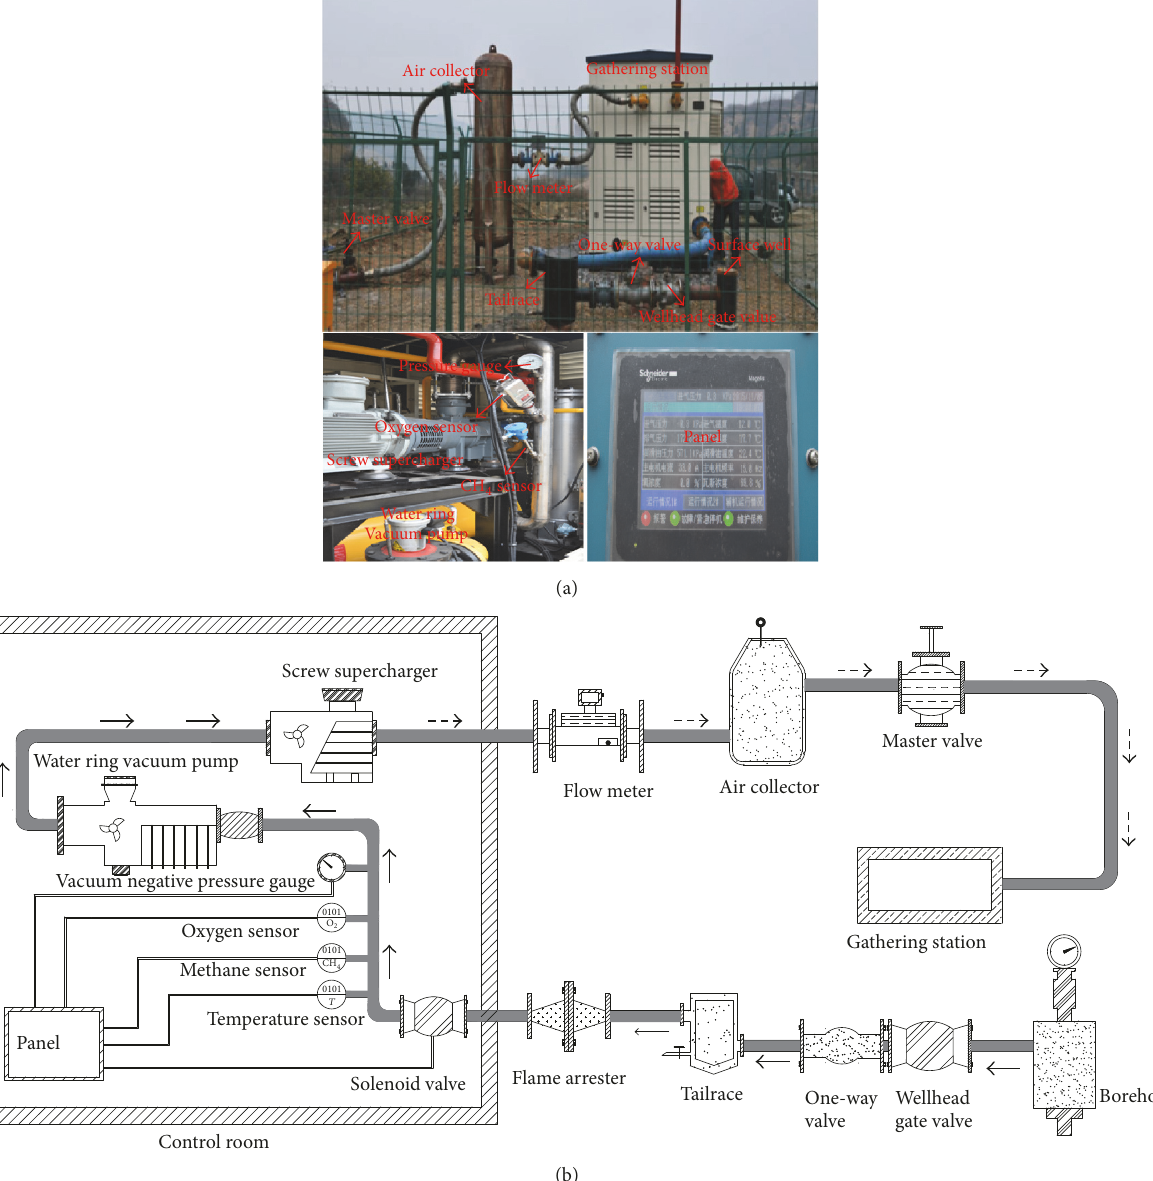
Figure 4: Surface methane drainage system: (a) physical image map and (b) schematic